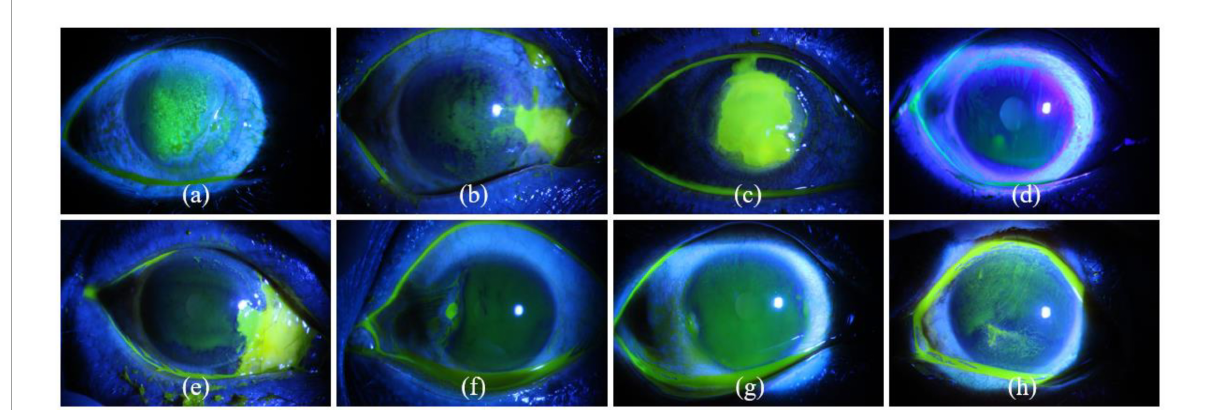
FIGURE1 Eight examples of slit lamp images of corneal ulcers. Panels (a–c) represent point-like corneal ulcer, point-flaky mixed corneal ulcer, and flaky corneal ulcer according to general ulcer pattern, while panels (d–h) are type0, type1, type2, type3, and type4 corneal ulcers according to specific ulcer pattern.